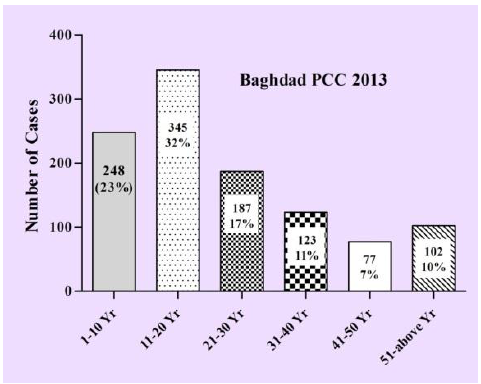
Figure (4): Distribution of poisoning cases